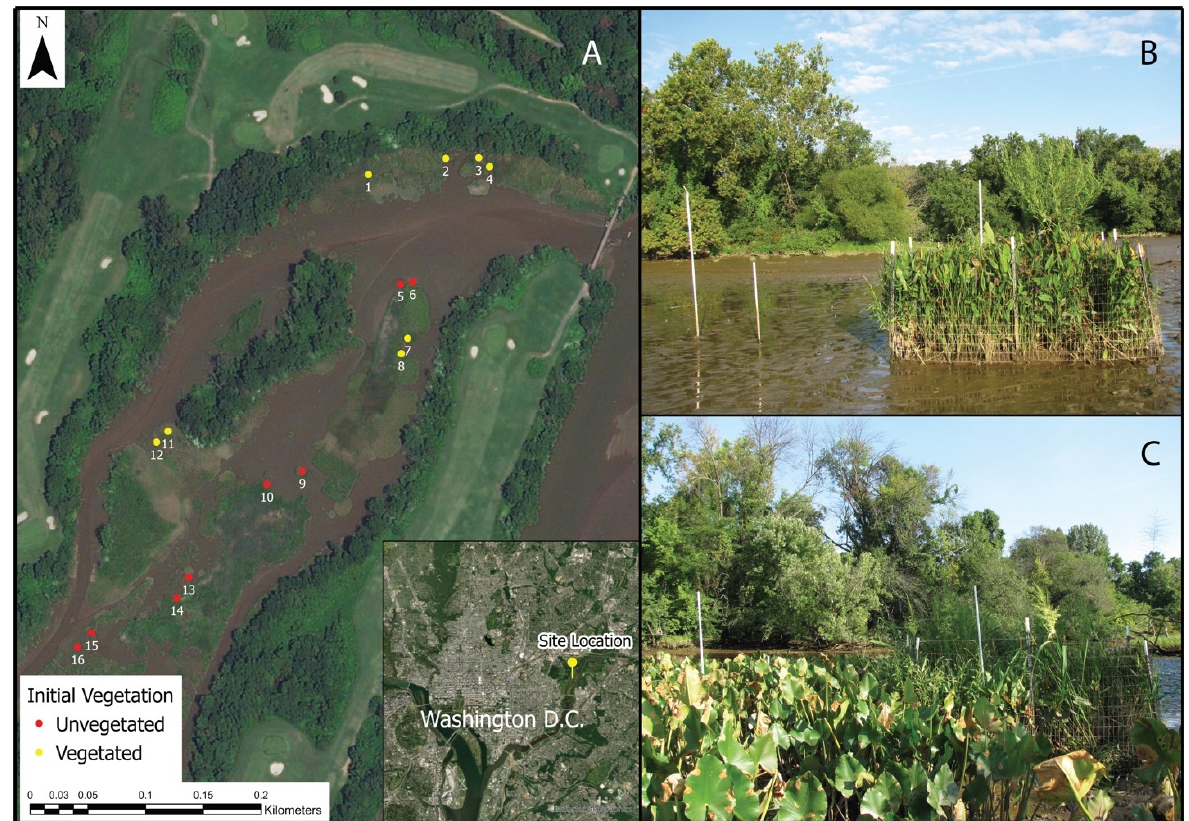
Figure 1. ( A ) Satellite image of the site, Kingman Marsh, with points to show each module and an inset to show the location of the marsh in Washington D.C., USA. Photos show a fenced and unfenced pair of plots in ( B ), an initially unvegetated module (number 5 in ( A )), ( C ) an initially vegetated module (number 11 in ( A )). Photos were taken in August 2015. Plot corners are designated with white PVC pipes (partially obscured by vegetation in the initial vegetated module).